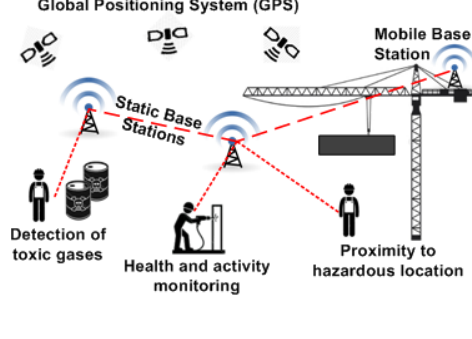
Figure 4. WBANs for Mobile Workforce Safety and Health Management Application Use-Case